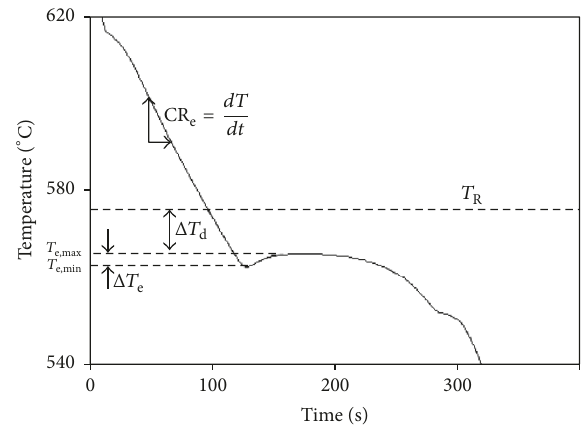
Figure 2: Solidification parameters of 356 alloy